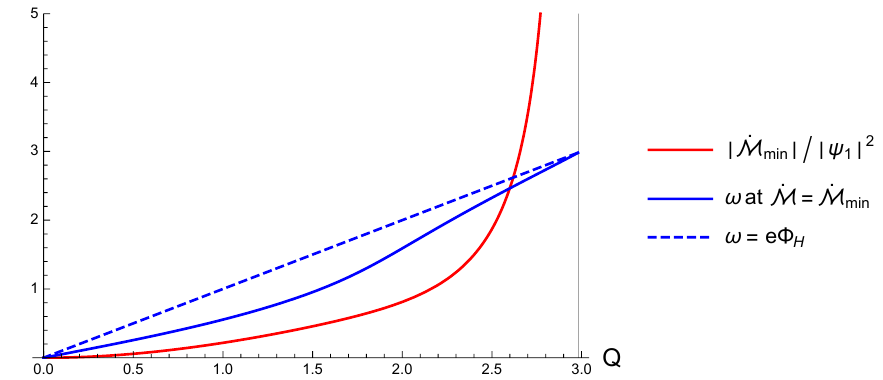
Figure 3 . Maximum energy extraction rate with respect to Q . The red line is the maximum extracted energy per unit time | ˙ M min | / | ψ 1 | 2 , the blue line is the corresponding frequency, and the blue dashed line shows ω = e Φ H . The black grid line at Q = 2 . 981 is the location of the onset of